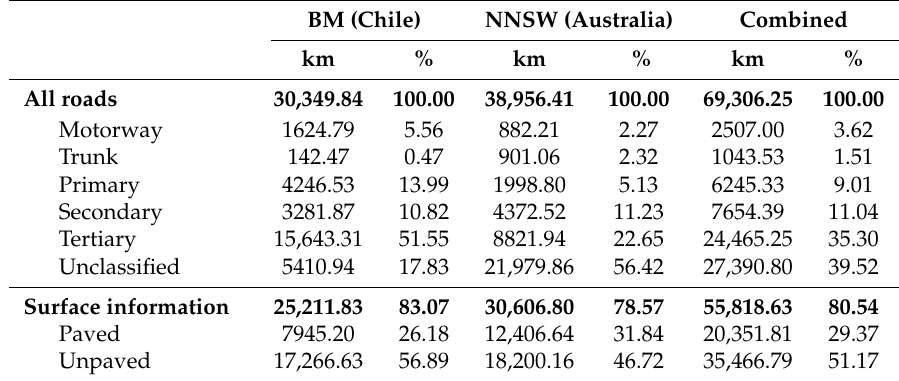
Table 2. Overview of the OSM road network data for the BioBío and Maule (BM) regions in Chile, for the north of New South Wales (NNSW) in Australia and for the combined dataset. Adapted from